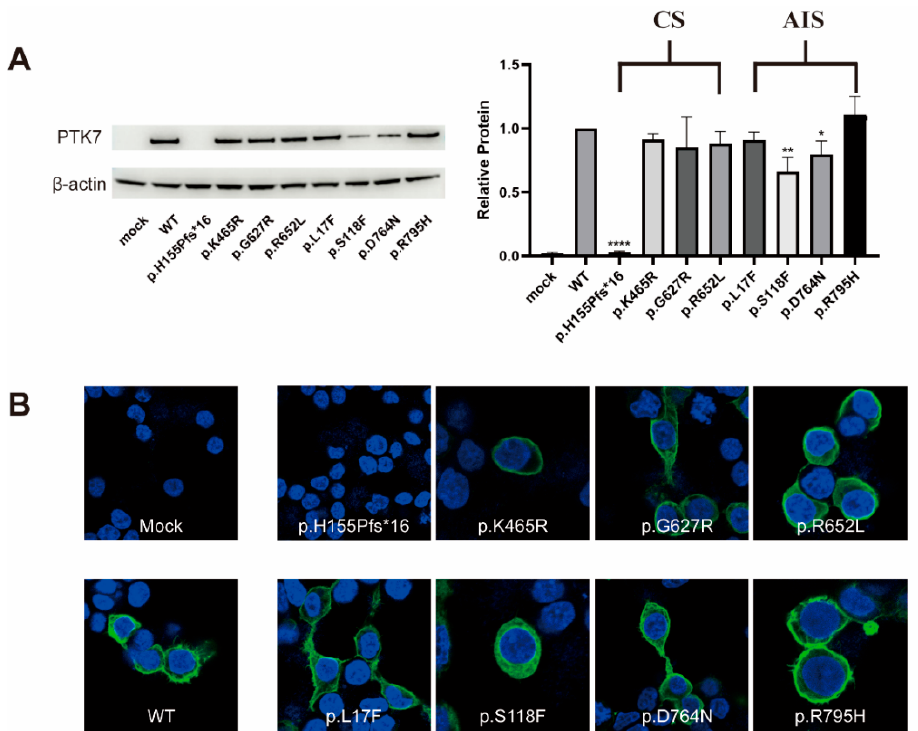
Figure 3. Western blot and ICC analyses. ( A ) HEK293T cells transiently transfected with WT or variant PTK7 constructs revealed diminished PTK7 protein expression levels of p.H155Pfs*16, p.S118F and p.D764N. * p value < 0.05, ** p value < 0.01, **** p value < 0.0001. ( B ) ICC assays showed a faint signal of the frameshift variant PTK7 protein. No difference in PTK7 protein sub-cellular location was